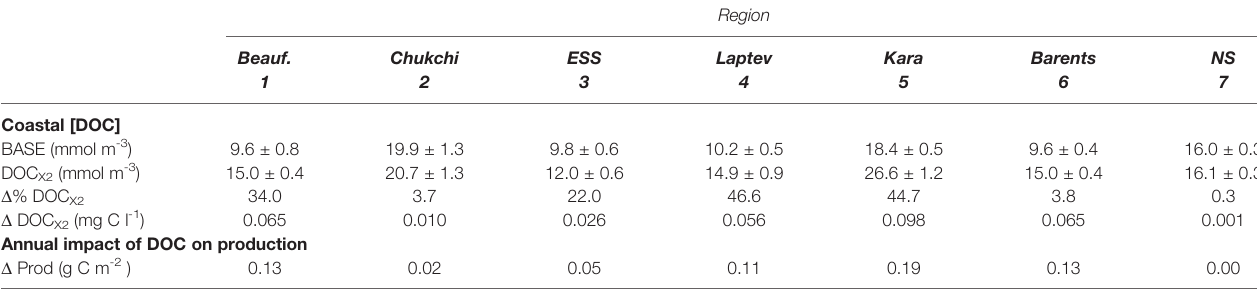
TABLE 4 | Summary of summer (June-August) average regional DOC concentration in the baseline model (BASE) and a scenario in which river [DOC] was